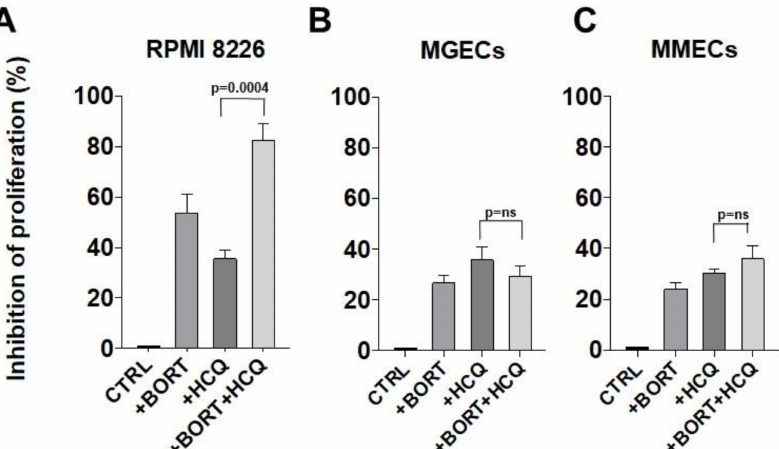
Figure 6. Bortezomib and HCQ di ff erentially modulate MM cell proliferation. RPMI 8226 cells ( A ), MGECs ( n = 6) ( B ), and MMECs ( n = 6) ( C ) were treated with or without bortezomib (10 nM), HCQ (100 uM) or with both drugs for 24 h, after which the inhibition of proliferation was evaluated by measuring cell viability. Mann–Whitney U test. ns = not